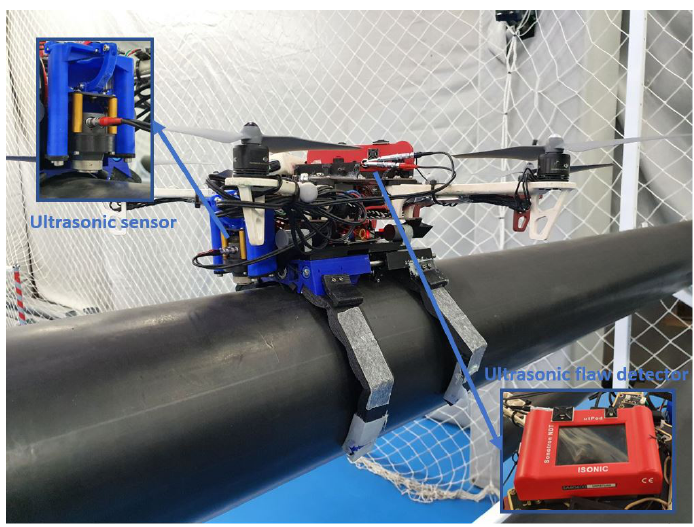
Figure 18. The image shows the complete system with an ultrasonic sensor and the flaw detection com-